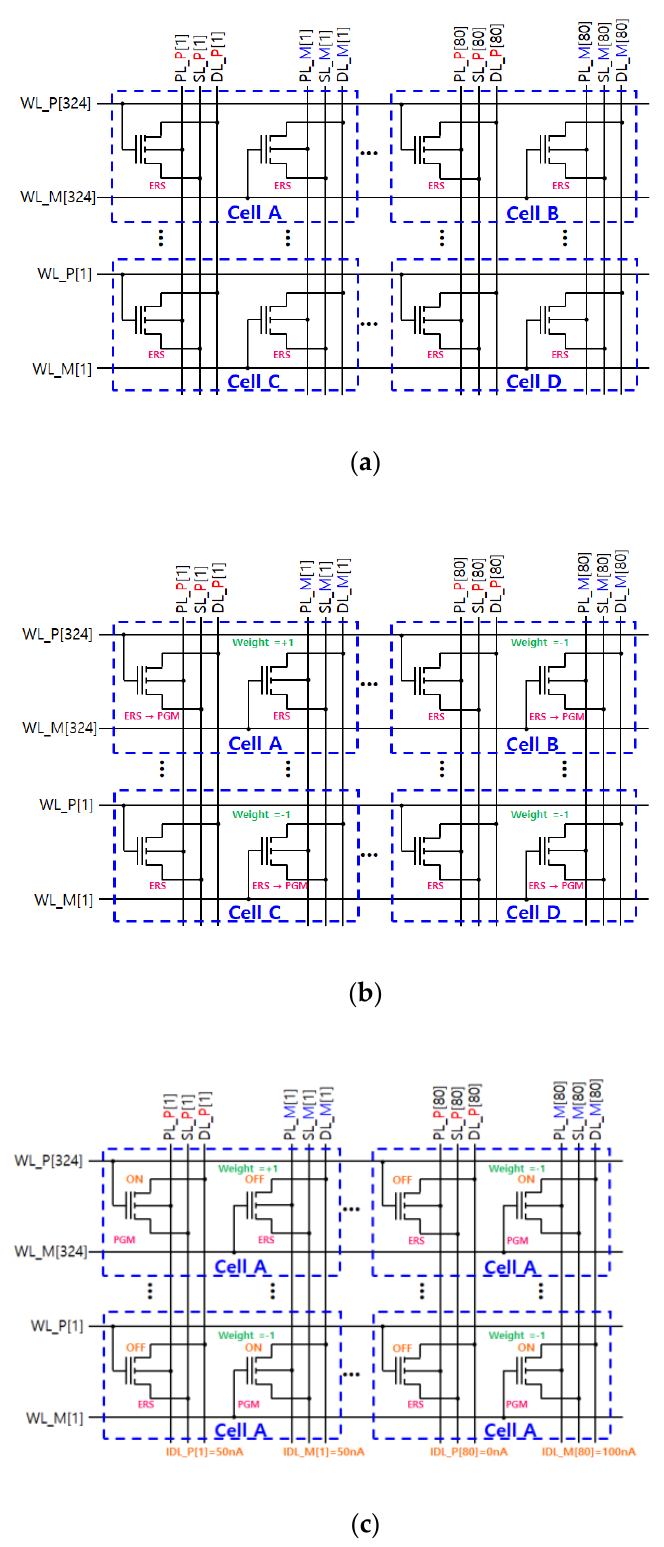
Figure 4. Erase, program and read operations in the 324 × 80 synapse array: ( a ) erase operation; ( b ) program operation; ( c ) read operation.